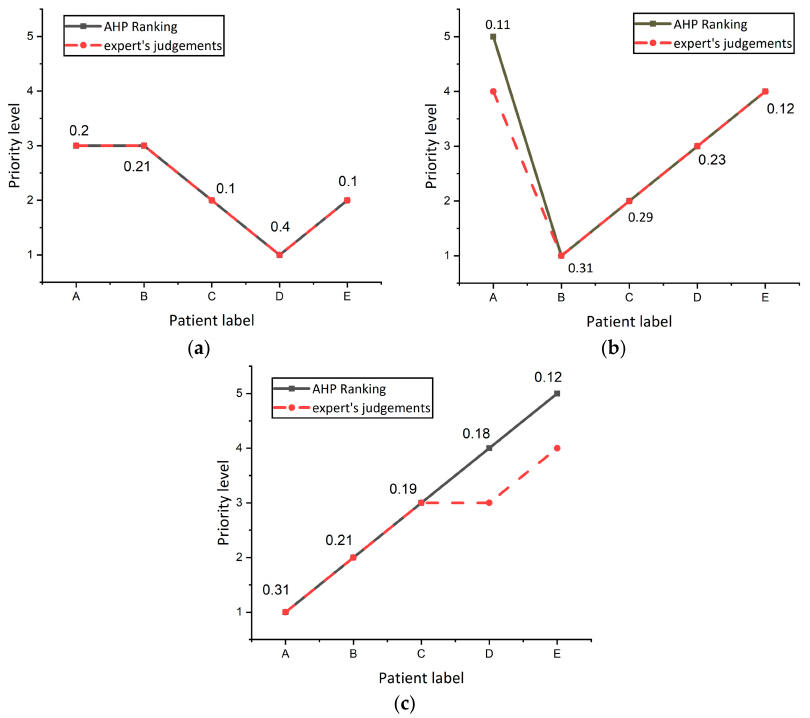
Figure 7. Investigate the variance in AHP and expert’s decision ranking ( a ) Experiment number 1. ( b ) Experiment number 2. ( c ) Experiment number